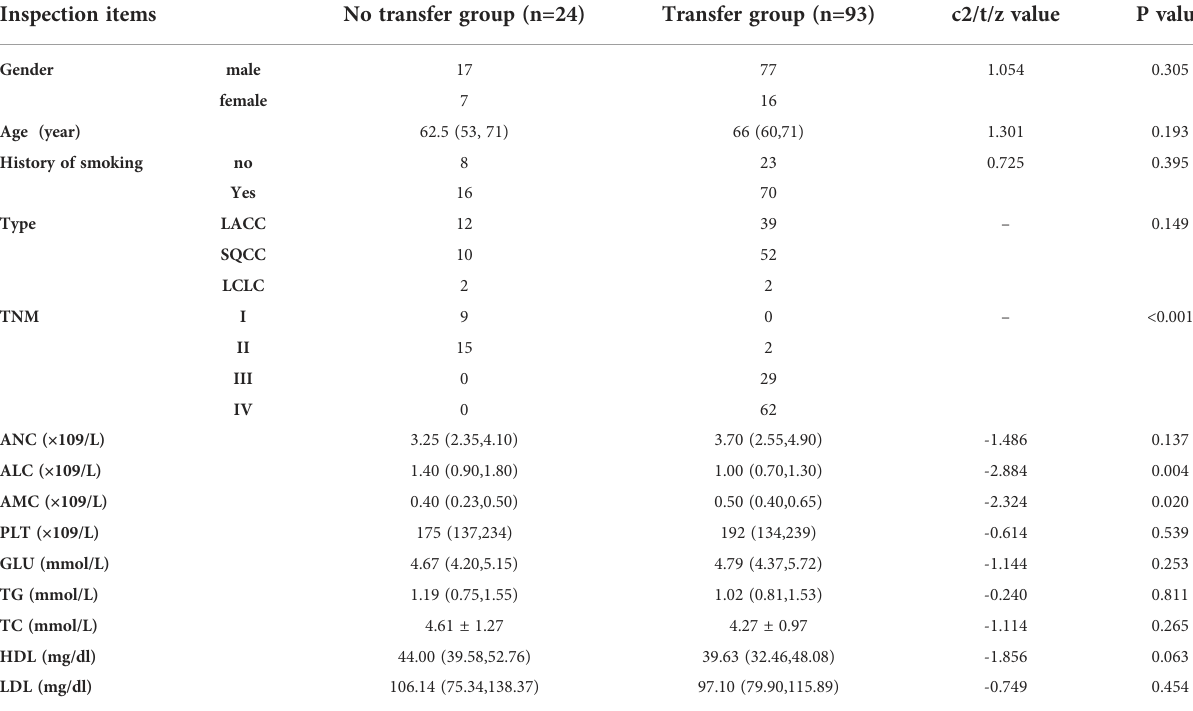
TABLE 1 The analysis of the clinical data of the NSCLC patients in the metastatic and nonmetastatic groups. Inspection